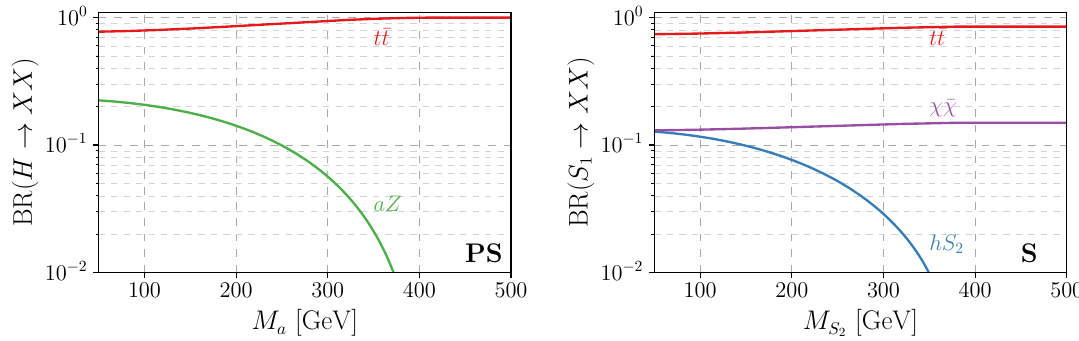
= M = H=S 1 H (cid:6)